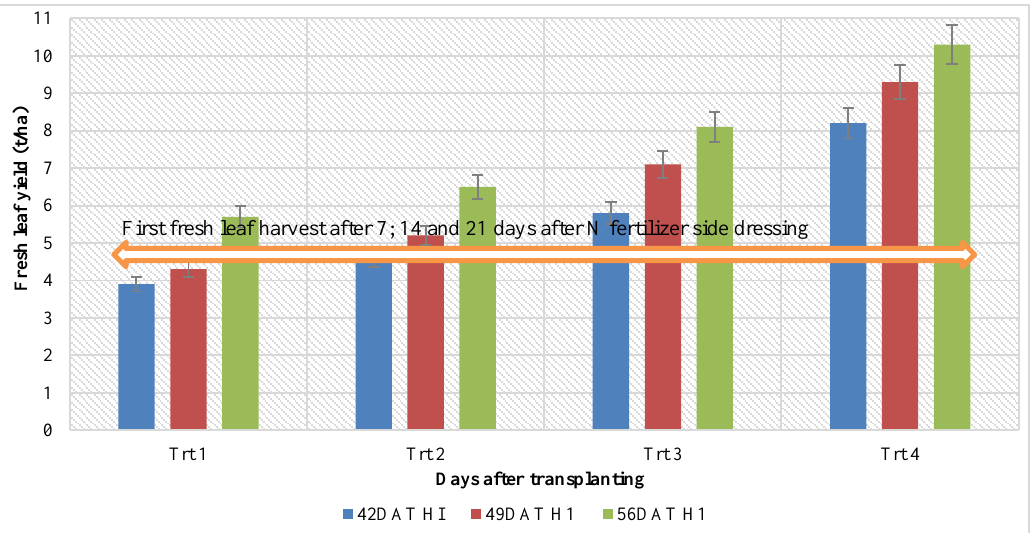
Figure 6b. Fresh leaf yield of the first harvest after N fertilizer side dressing at 35DAT (2015)